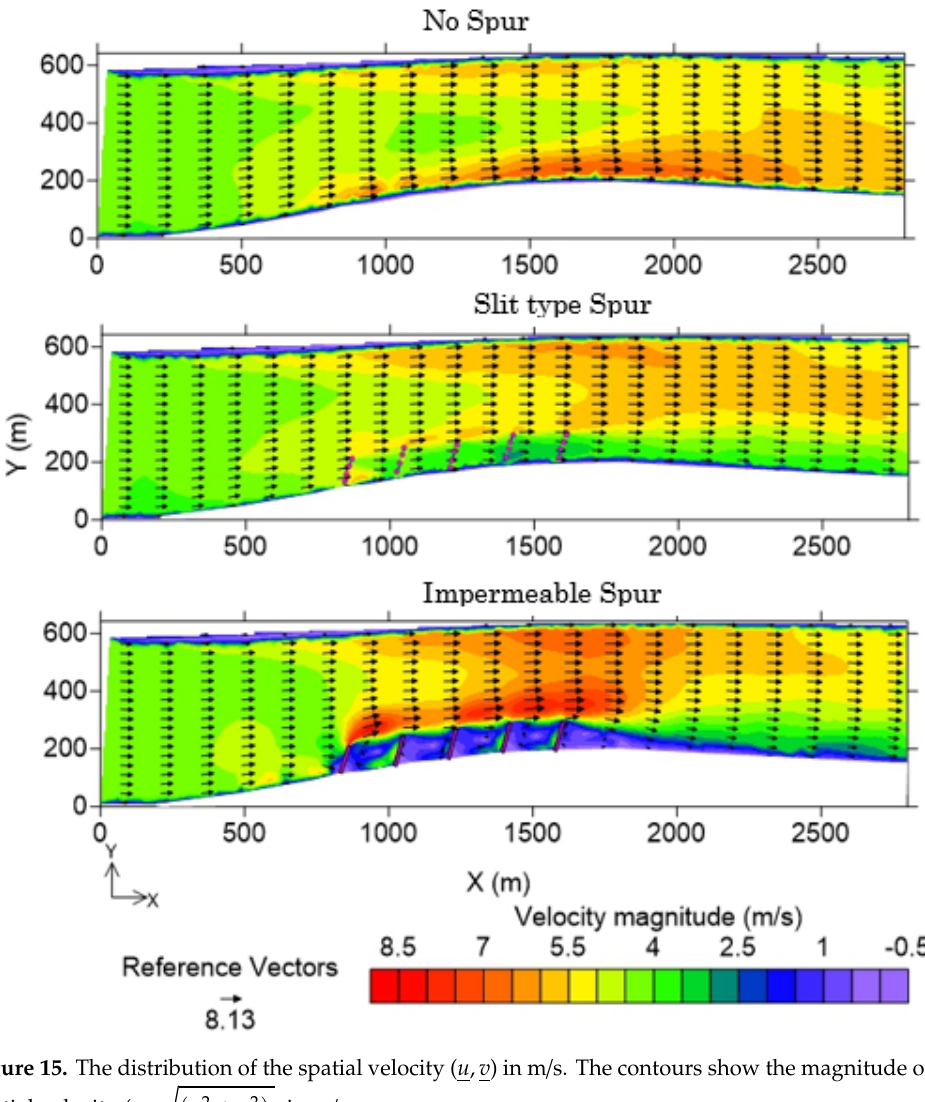
Figure 15. The distribution of the spatial velocity ( 𝑢, 𝑣 ) in m/s. The contours show the magnitude of the spatial velocity ( = (cid:3495)(cid:3435)𝑢 (cid:2870) + 𝑣 (cid:2870) (cid:3439) in m/s.